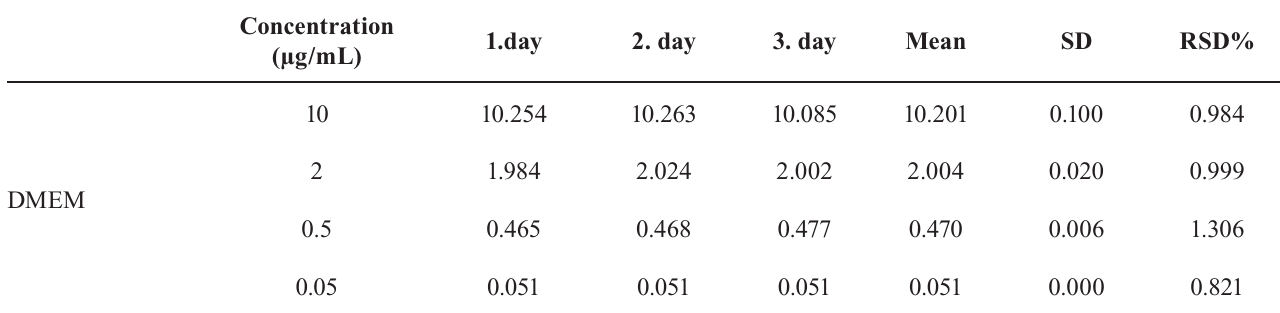
TABLE VI - Inter-day precision for dexketoprofen trometamol